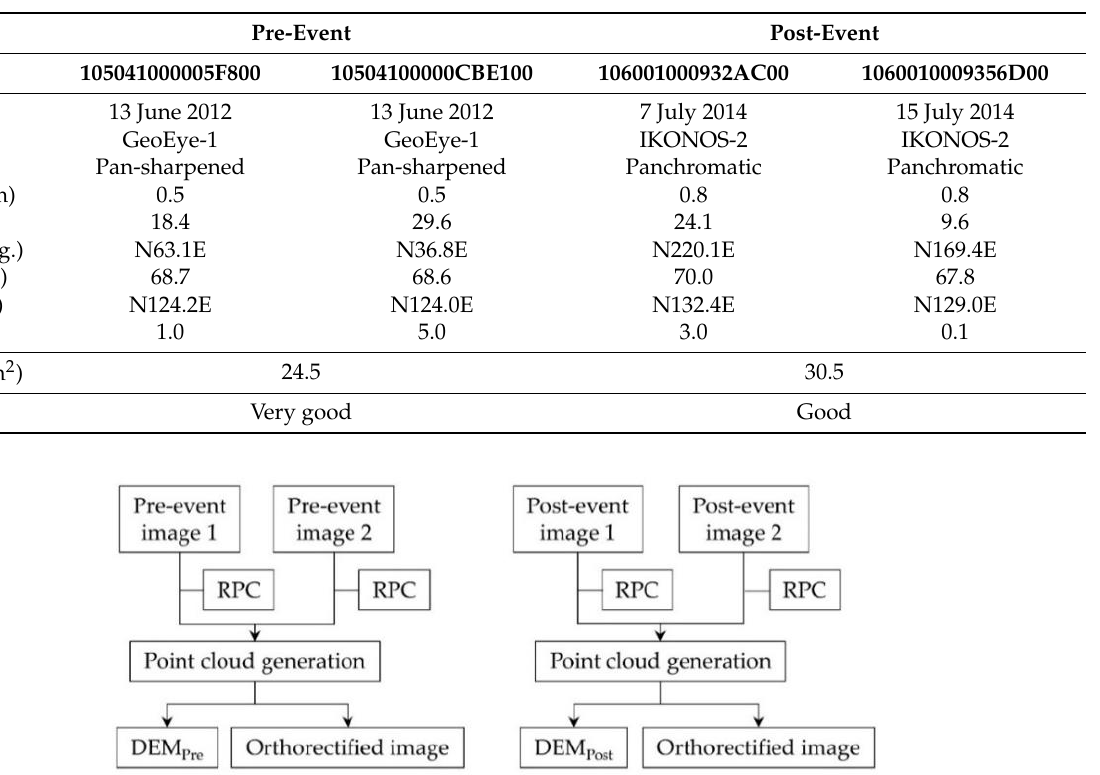
Table 1. Distinguished features of the satellite imagery used in this study and their observation conditions.